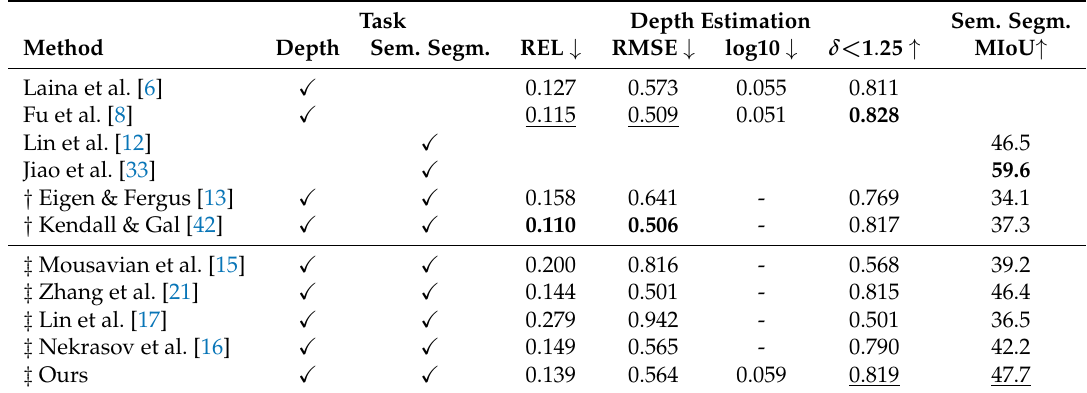
Table 1. Quantitative comparison against previous approaches on the NYU Depth v2 dataset. † denotes that two tasks use the same architecture but not the same weights. ‡ employs a single model for the joint task. The bold and underlined items represent the best and second place, respectively.